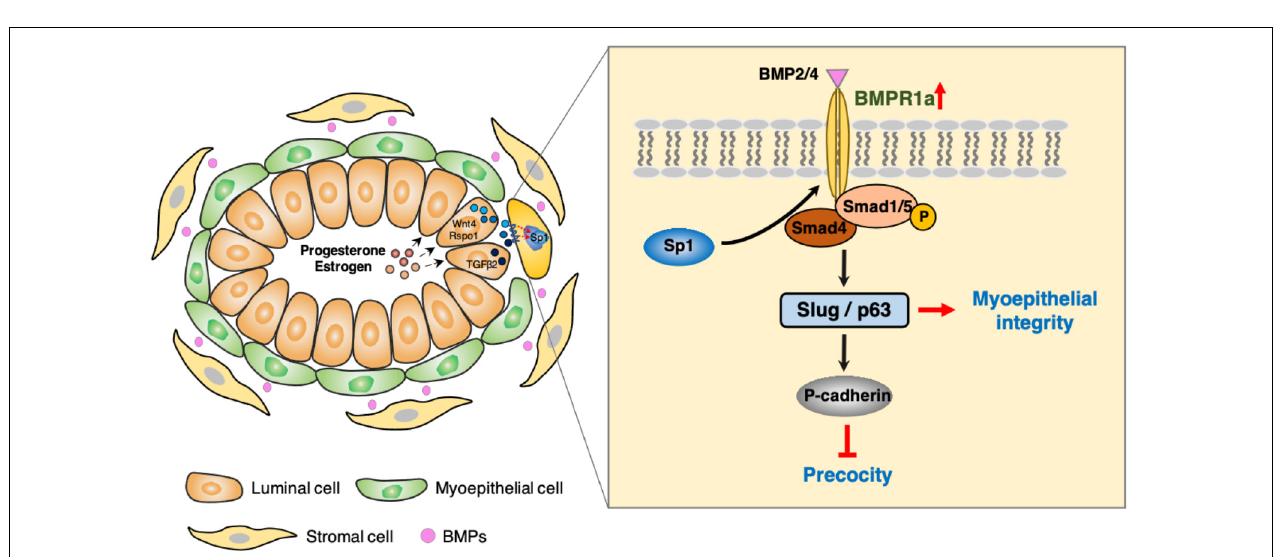
FIGURE 8 | Working model of the role of BMPR1a in regulating mammary myoepithelial